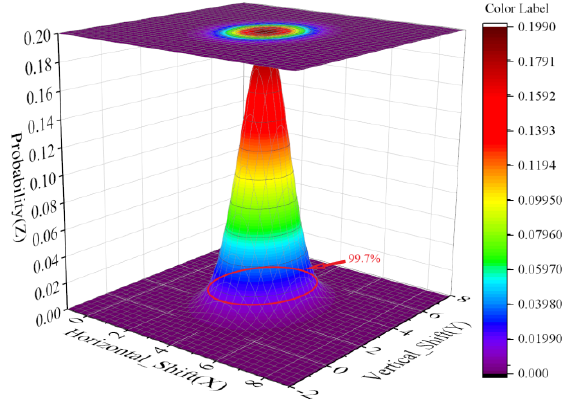
Figure 18. “Offset-probability” heat map of UAV route planning.